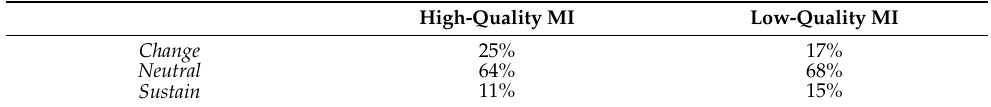
Table 12. Talk Type distributions in high- and low-quality